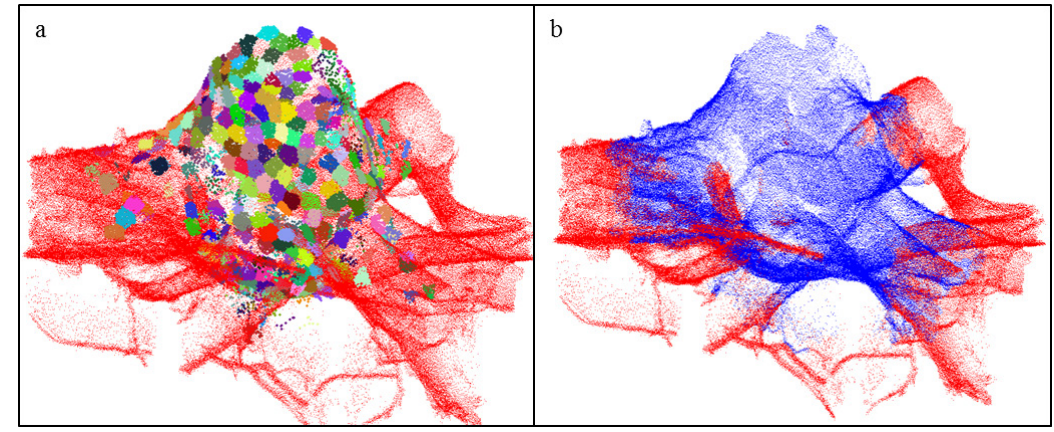
Figure 4. Determination of the stump portion of the point cloud: ( a ) Different colors denote the patches closest to the normal line in their cell; ( b ) The final stump portion is shown in blue.